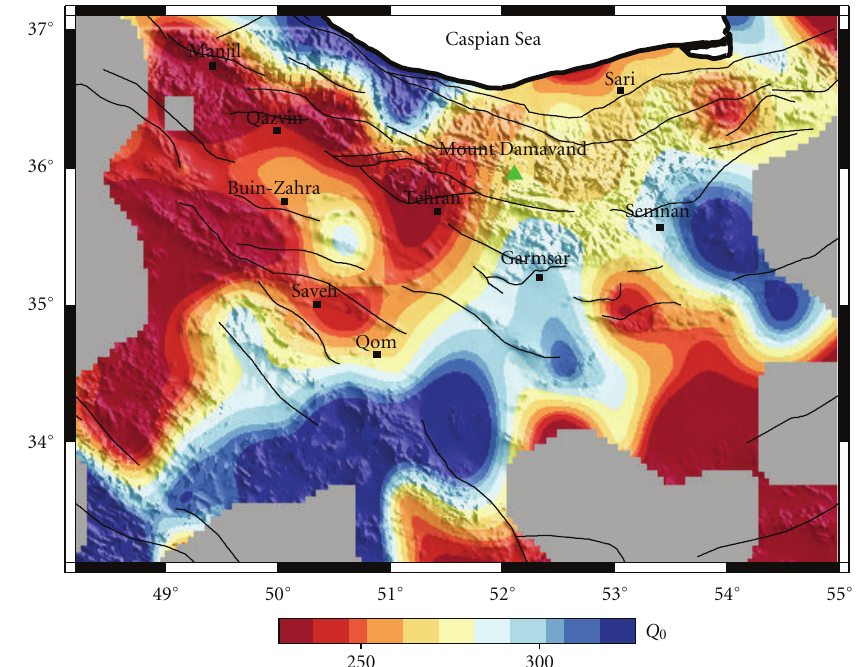
Figure 4: Q 0 variations in the study area. Triangles and squares show Damavand volcano and main cities, respectively. Major faults are marked by black